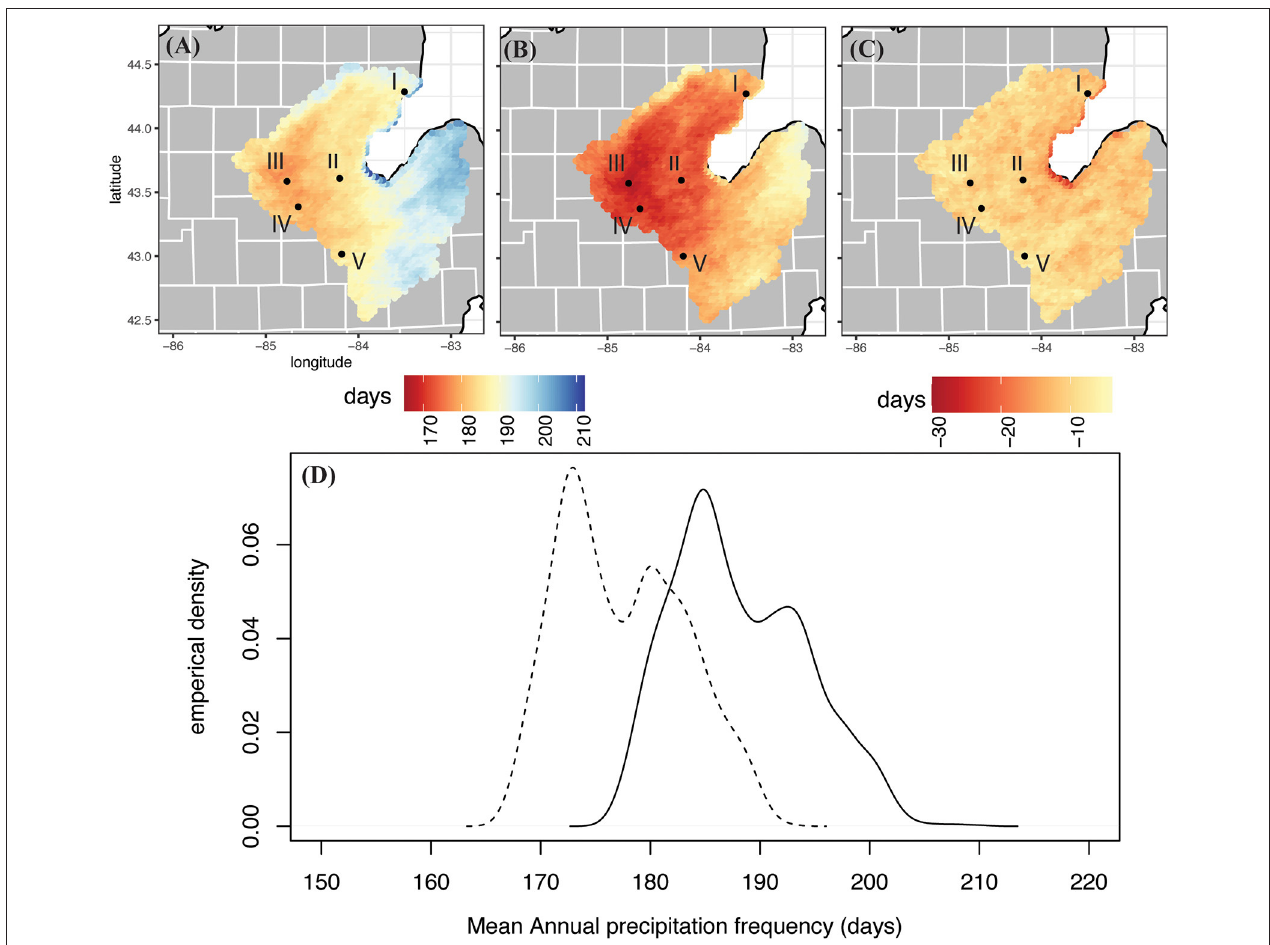
FIGURE 6 | Same as Figure 2 , but for mean annual precipitation